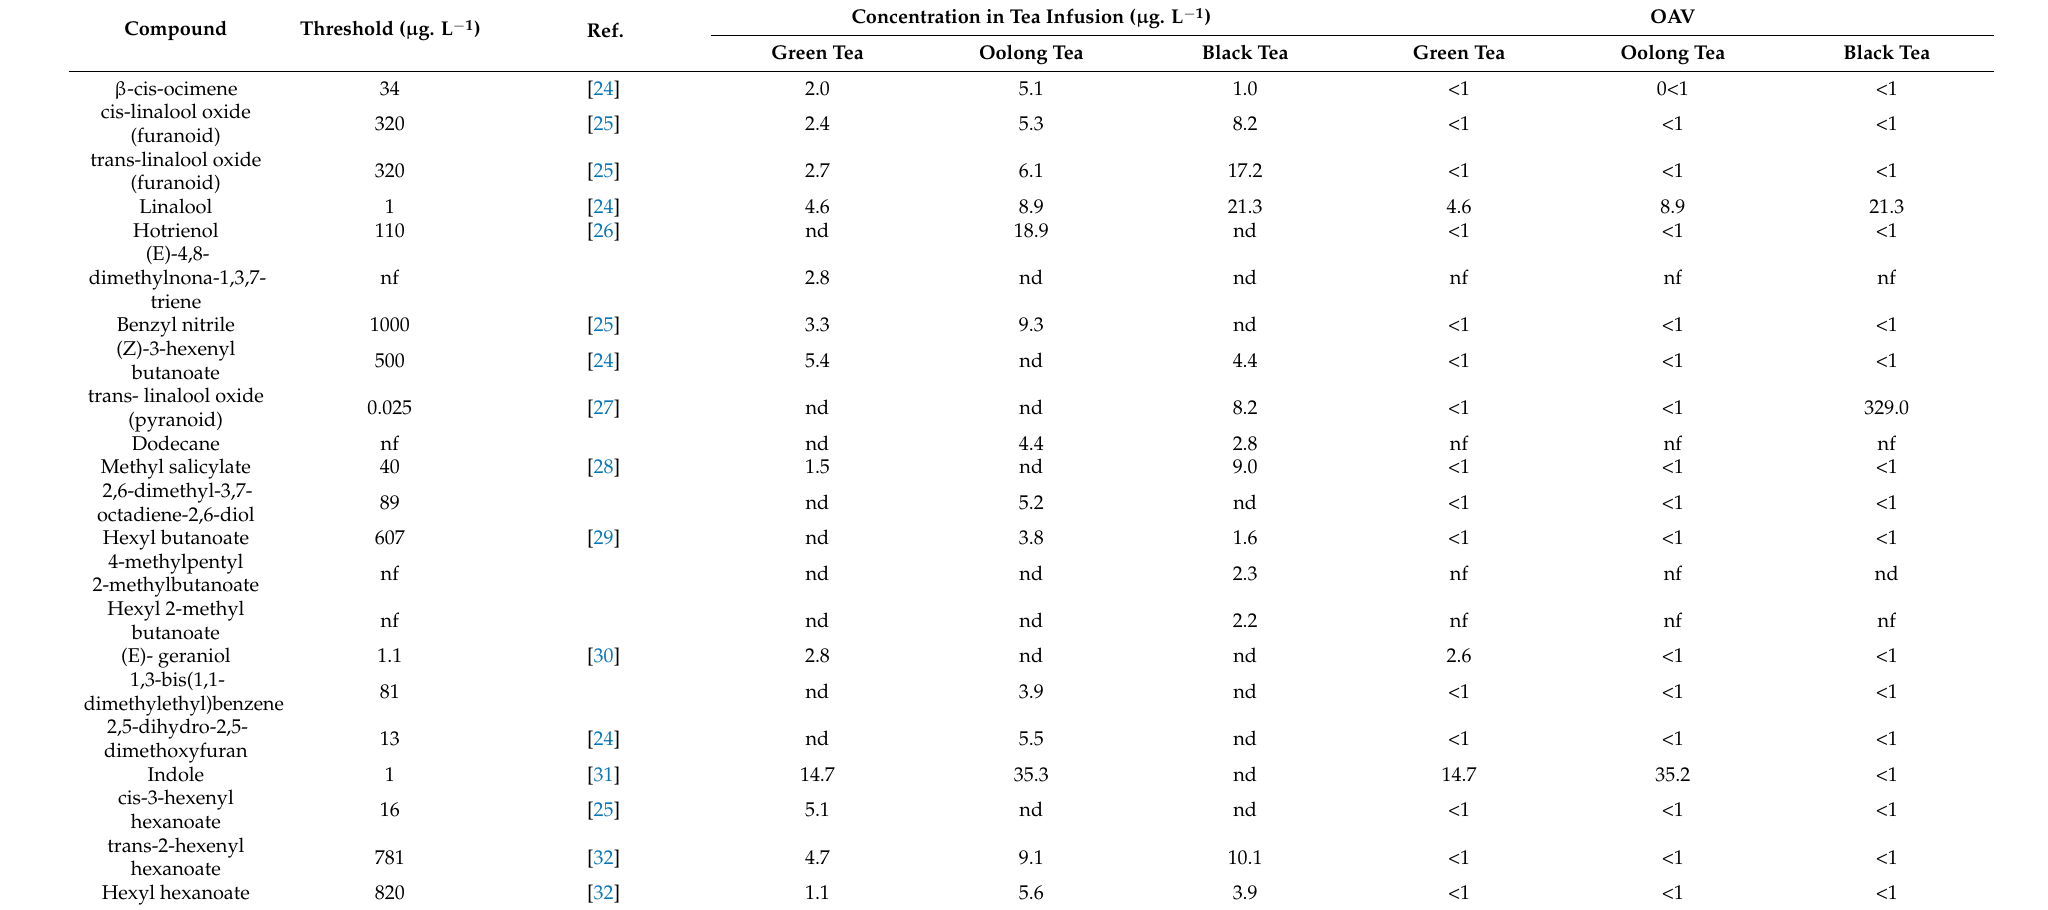
Table 2. Aroma contents from tea infusion and odor-activity value (OAV) of green tea, oolong tea, and black